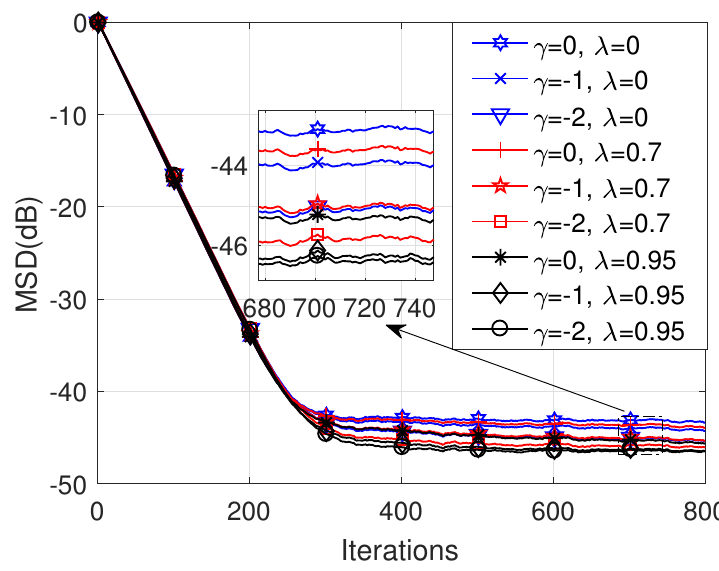
Figure 5. The MSD learning